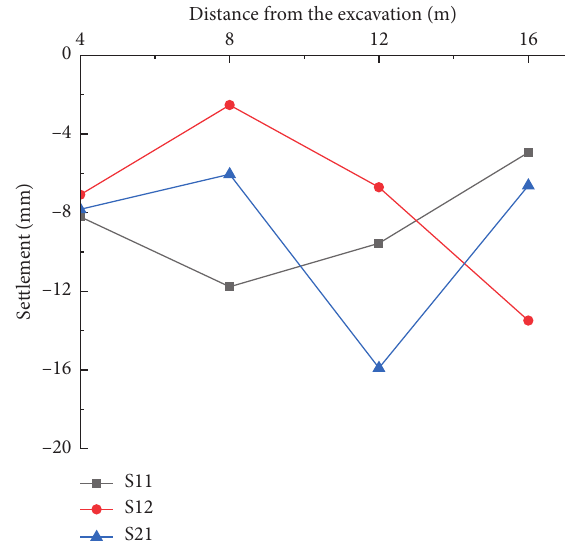
Figure 8: Settlement profile of S11, S12, and S21 measuring points when the excavation was